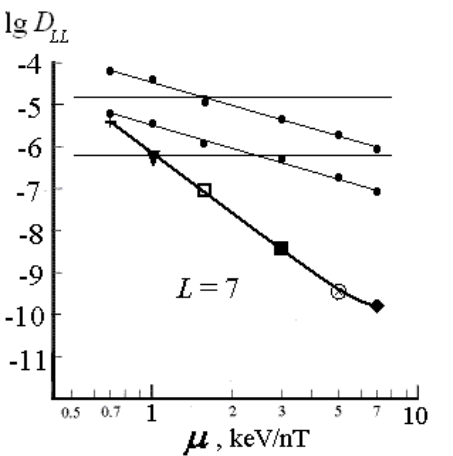
Figure 8. The dependences of D LL (µ) on different L (in the range from 4 to 10), which corresponds to the results shown in Fig. 5. Here D LL is given in values per